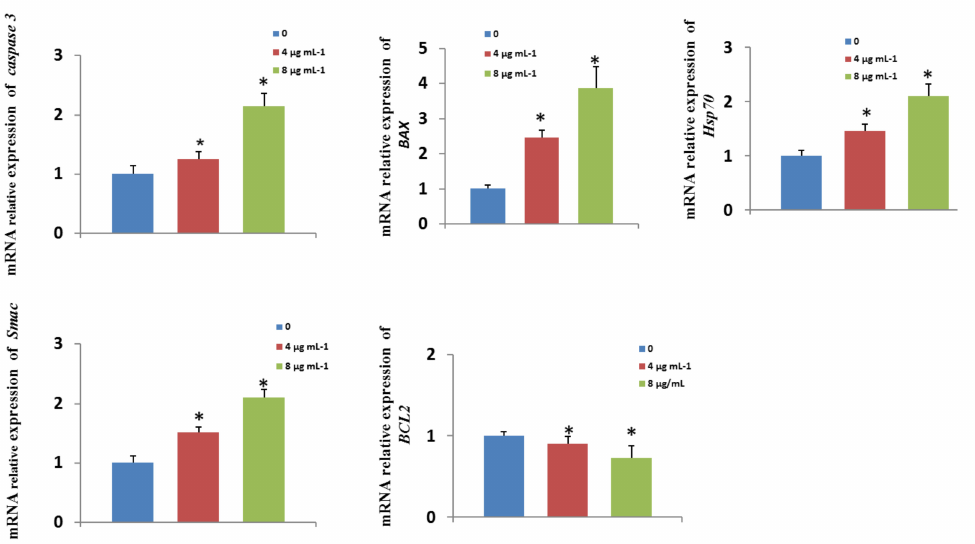
Figure 10. Effects of GO-AgNPs on apoptotic gene expression levels. Caprine fetal fibroblast cells (CFFCs) were treated with 0, 4, and 8 µ g/mL of GO-AgNPs for 24 h. Relative mRNA levels of genes related to apoptosis were determined. Values are presented as the mean ± SD of four independent experiments (* p < 0.05).